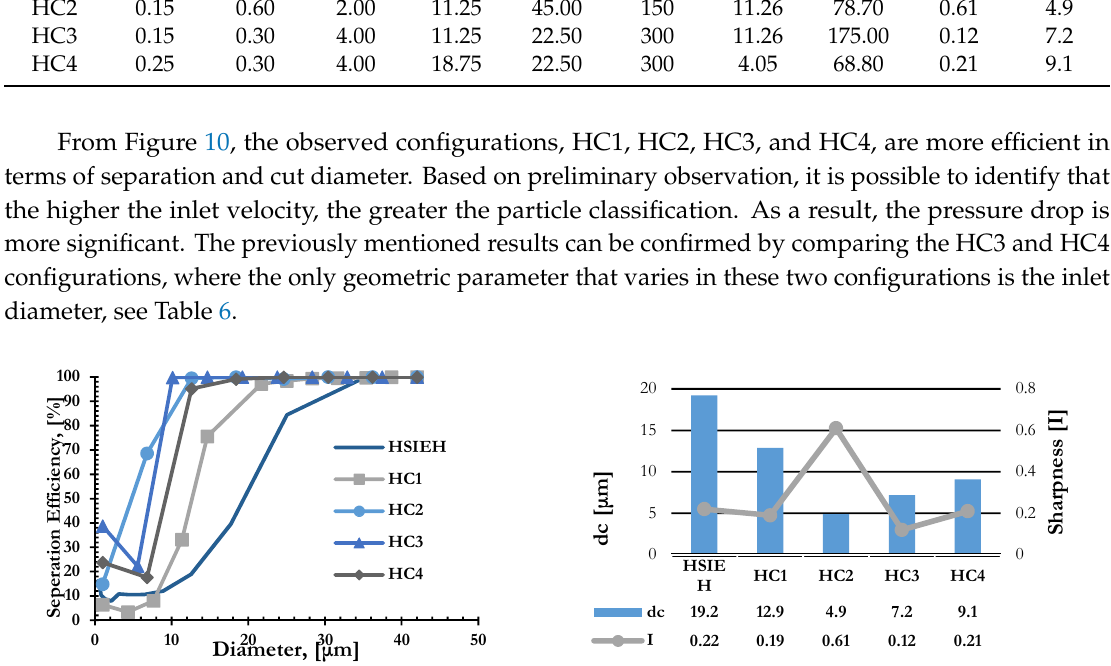
ffi ciency curve for the five hydrocyclones Figure 10. Efficiency curve for the five hydrocyclones evaluated. Figure 10. E